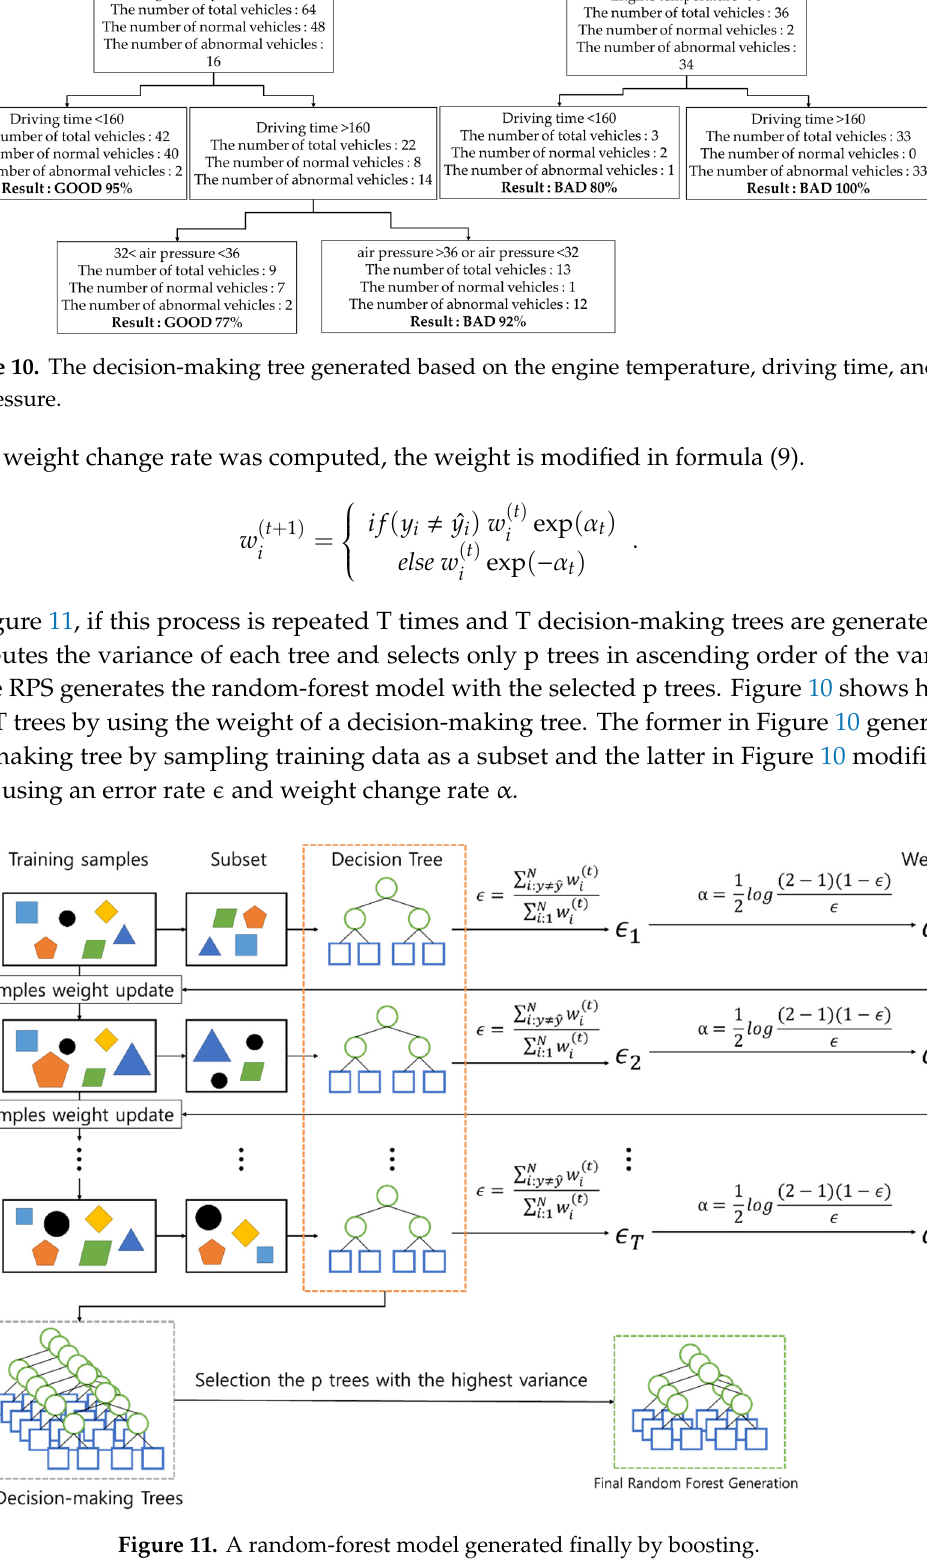
Figure 11. A random-forest model generated finally by boosting.